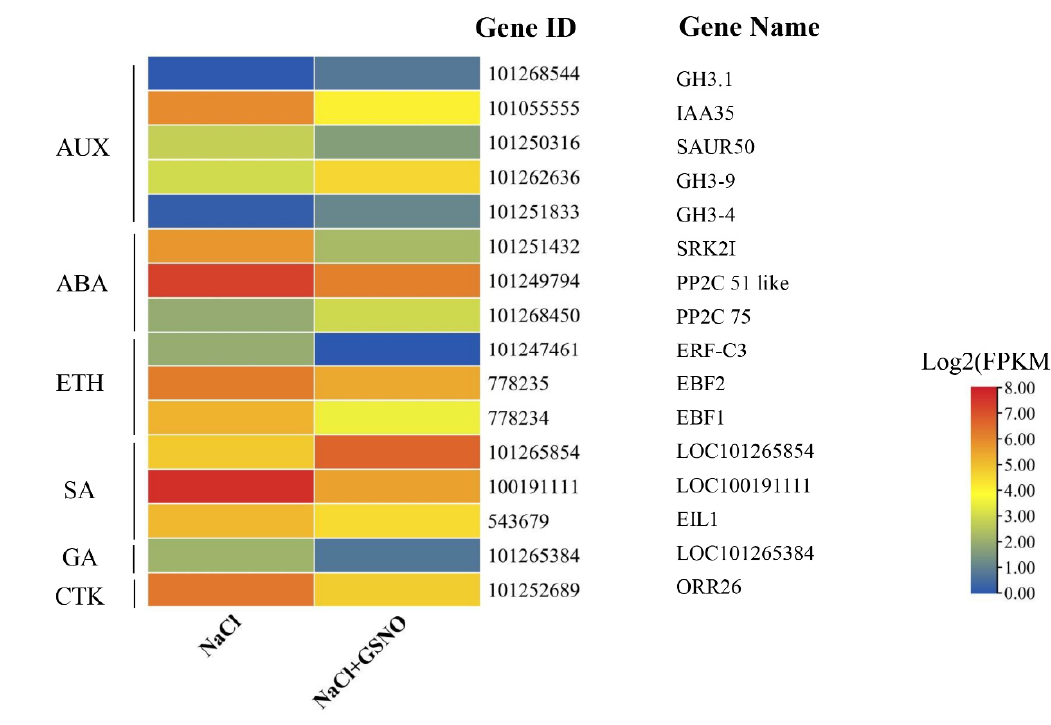
Figure 3. The heatmap of the expression of DEGs related to plant hormone signal transduction in NaCl and NaCl + GSNO treatments. The color scale corresponds to log 2-transformed (fragments per kilobyte per million reads) FPKM values. Red represents upregulation and blue represents downregulation of DEG expression.